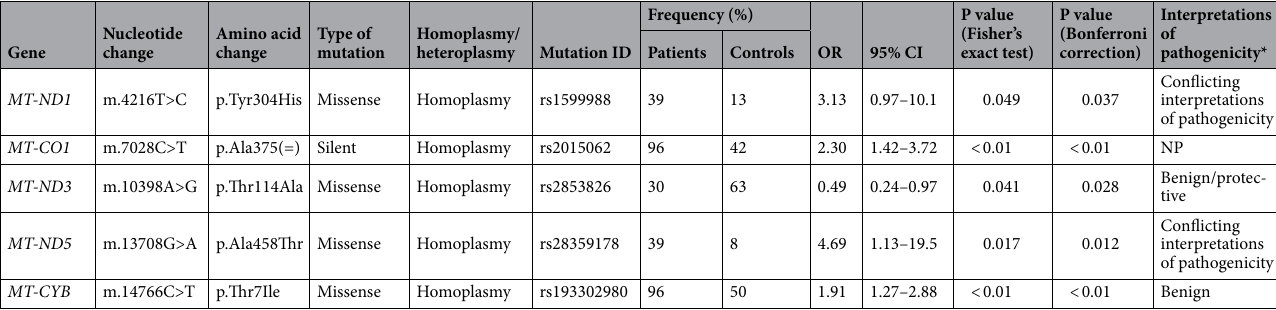
Table 5. LHON-related mtDNA mutations in RRMS patients and healthy controls. LHON Leber’s hereditary optic neuropathy, RRMS relapse-remitting multiple sclerosis, OR odds ratio, CI confidence interval, NP not provided. *Interpretation was reported according to ClinVar